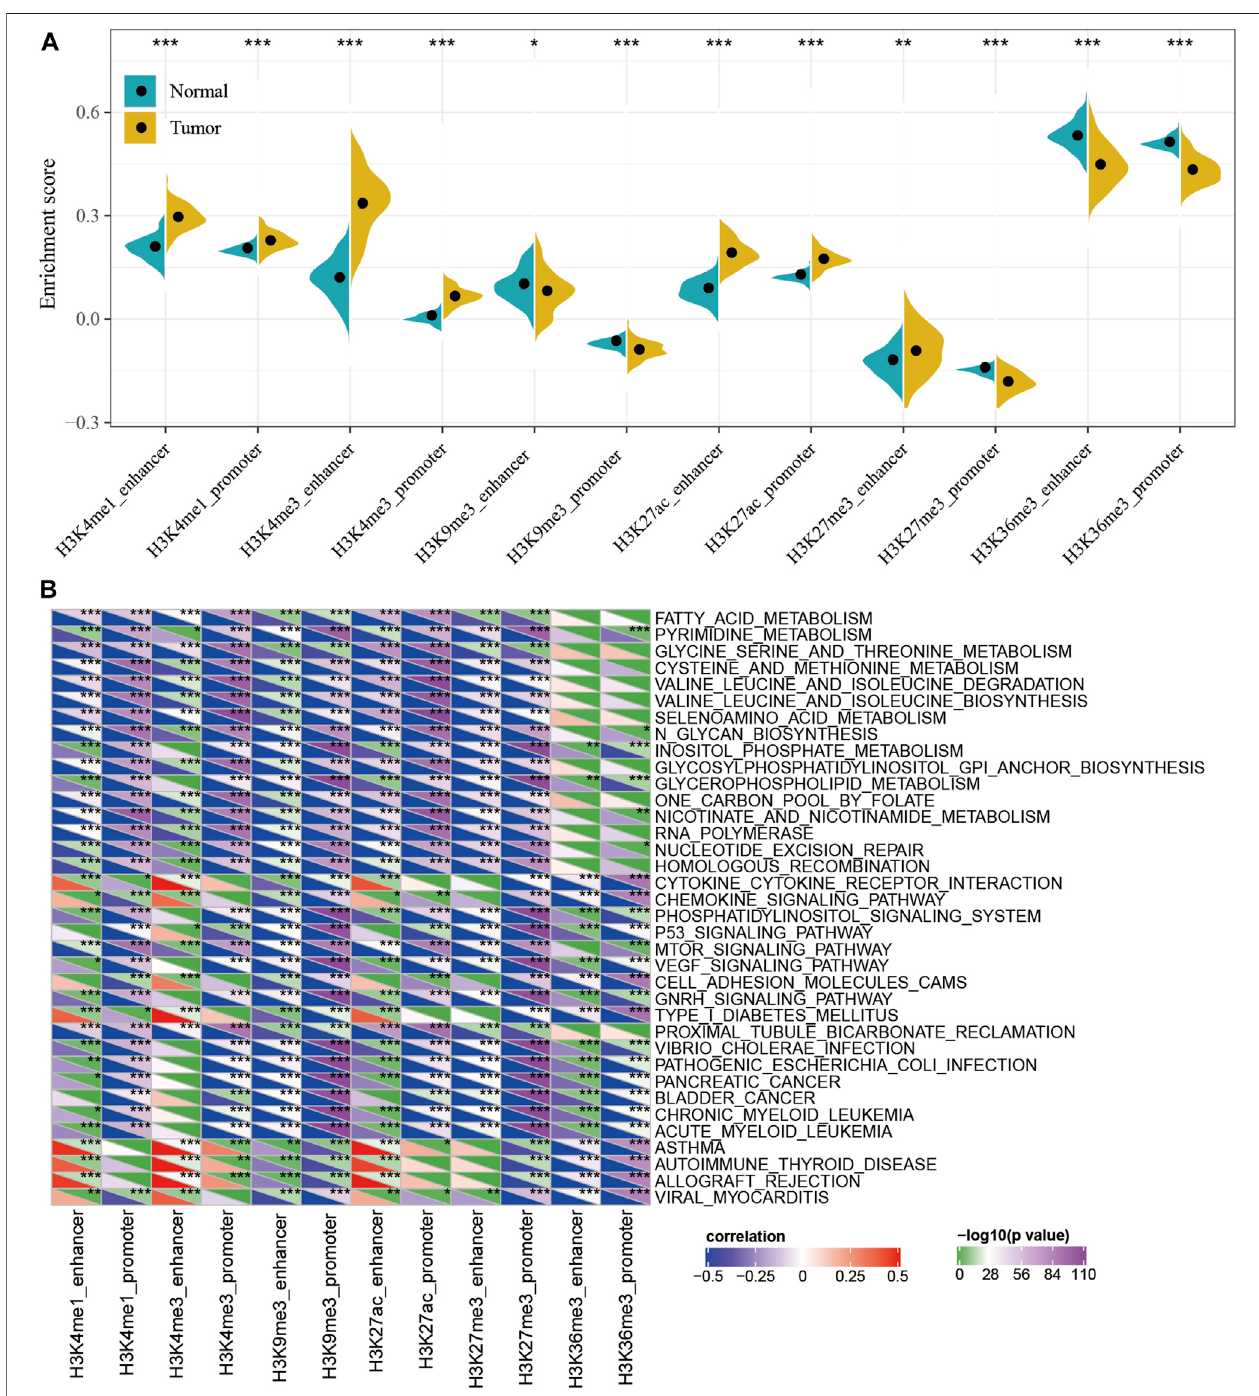
FIGURE 3 | Functional analysis for epi-lncRNAs. (A) Differences in 12 kinds of apparent epigenetic dysregulations in lncRNAs between cancerous and adjacent non-cancerous samples; (B) KEGG pathways most signi fi cantly associated with the 12 apparent epigenetically dysregulated lncRNAs.